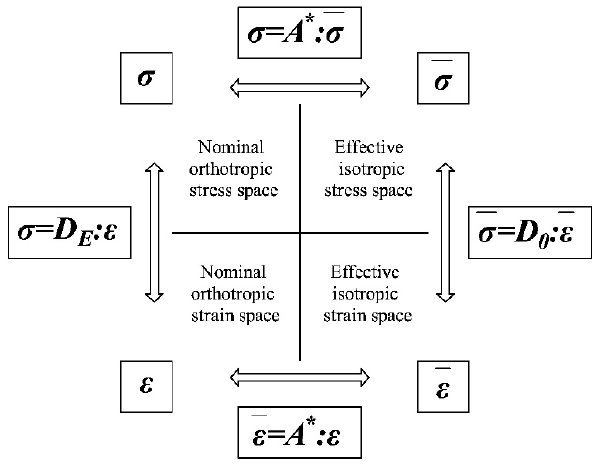
Figure 1. Energy equivalence hypothesis: relations between effective and nominal spaces.